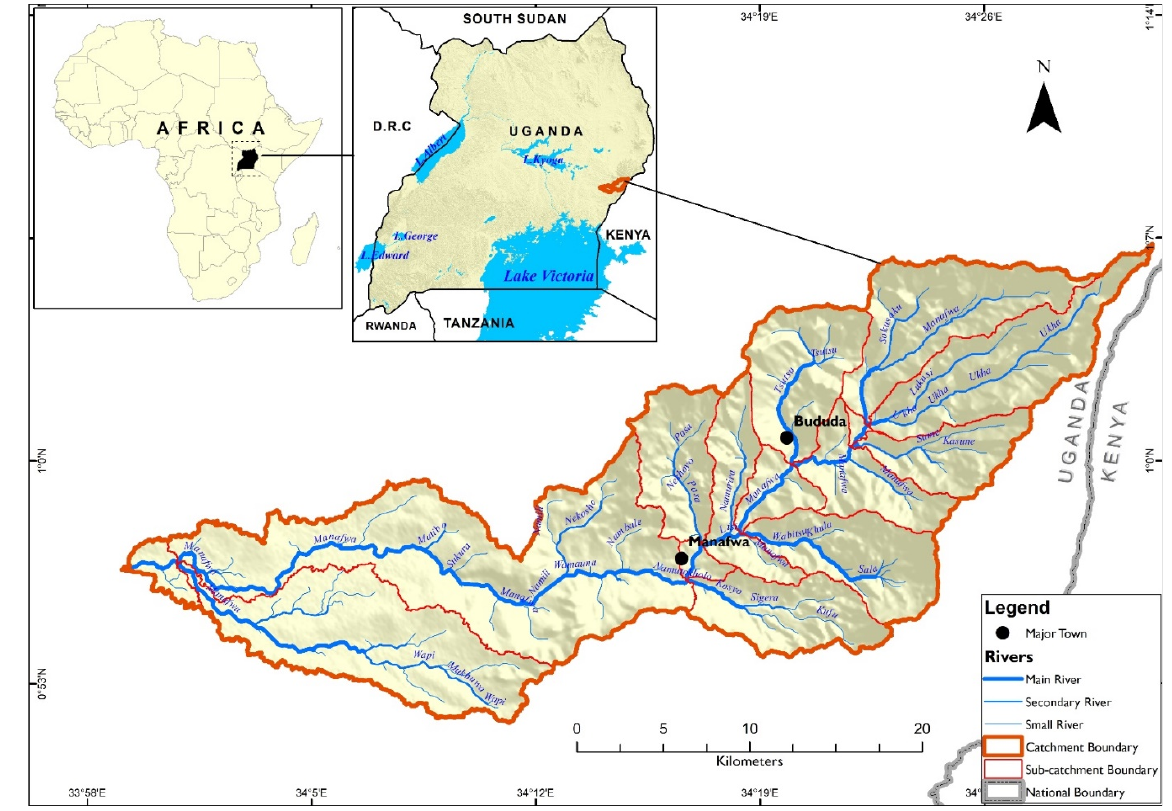
Figure 1. Map of the study area.